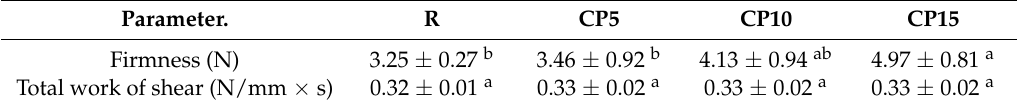
Table 4. Texture of pasta.